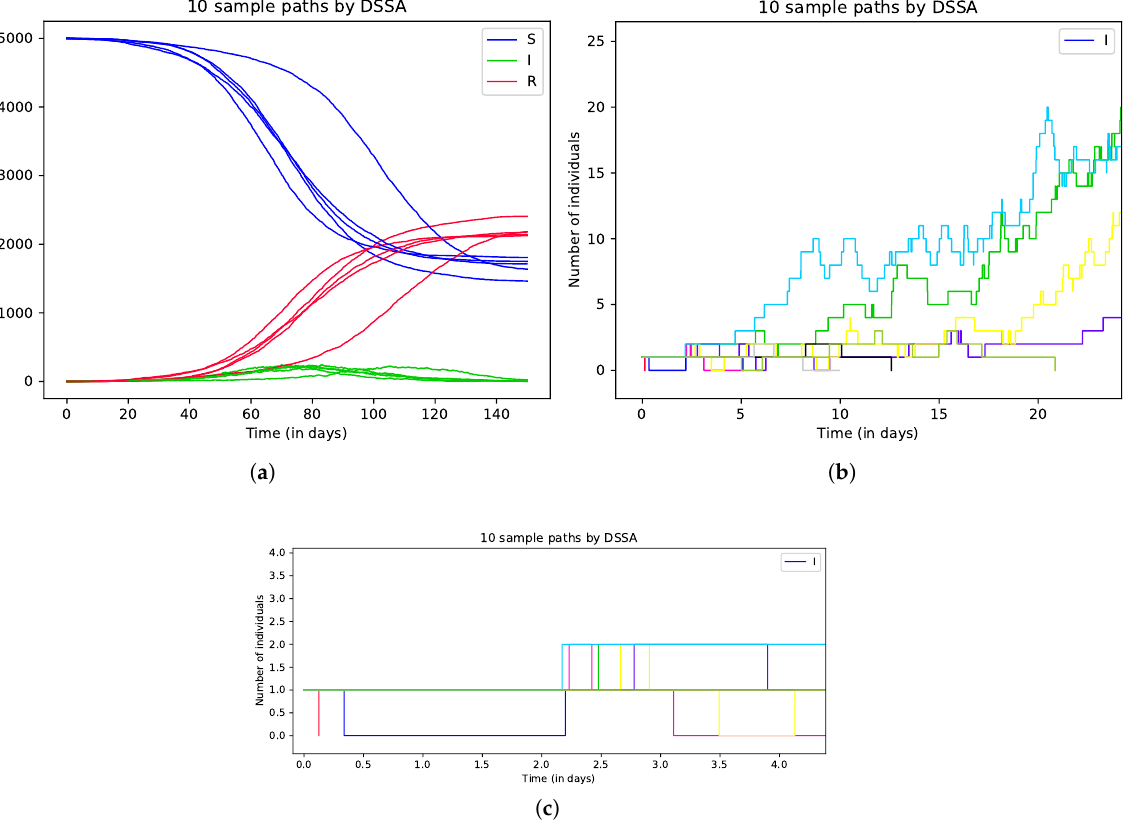
Figure 4. Simulation of 10 realizations generated by DSSA for delayed stochastic epidemic model (1). Sub-figures ( b , c ) are the zoomed-in views of the 10 realizations in sub-figure ( a